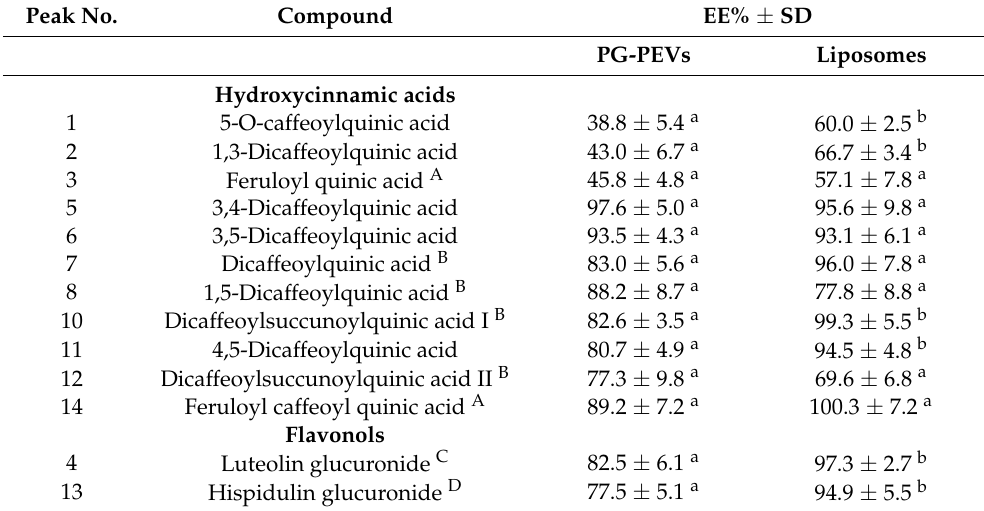
Table 5. Entrapment efficiency (EE%) of the main phenolic compounds identified in O. illyricum extract. Peak No.